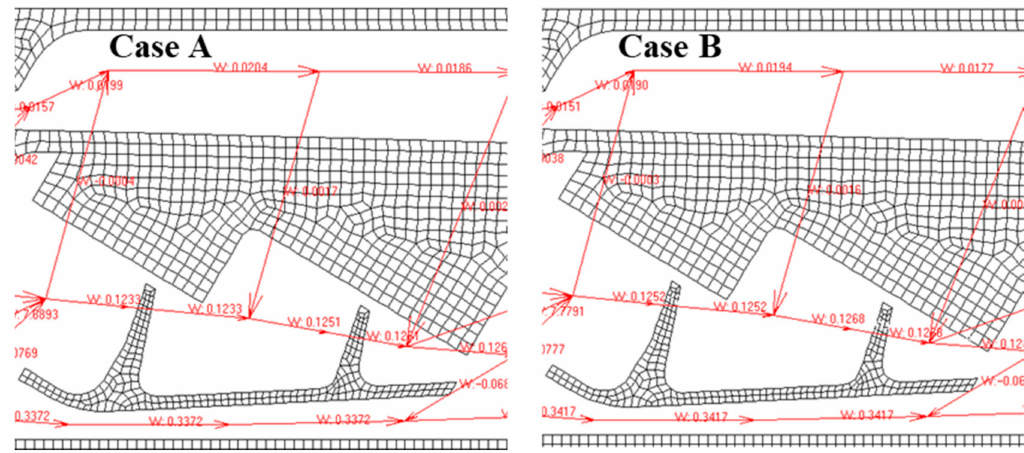
Figure 14. Thermalcase model: Mass flow split in the sealing region with a Flow Path temperature of 873 K and a Cooling temperature in Case A ( left ) of 473 K and in Case B ( right ) of 573 K.